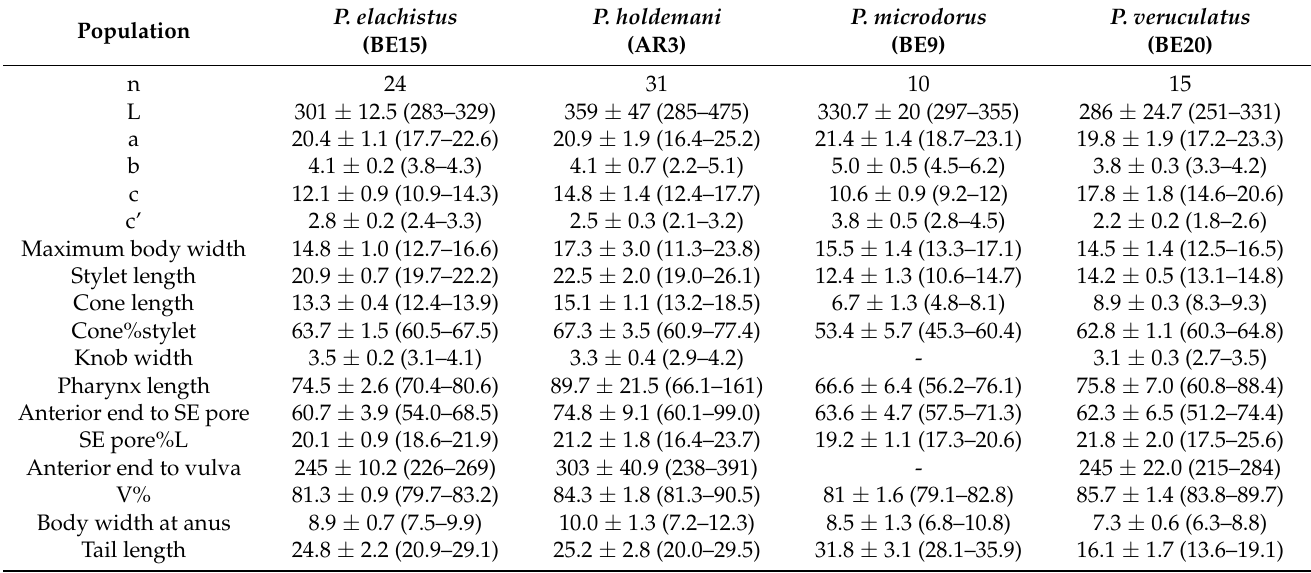
Table 3. Female morphometrics of Paratylenchus elachistus , Paratylenchus holdemani , Paratylenchus microdorus and Paratylenchus veruculatus from fixed specimens mounted in glycerine. All measurements except for ratios and percentages are given in µ m and in the form mean ± stdev